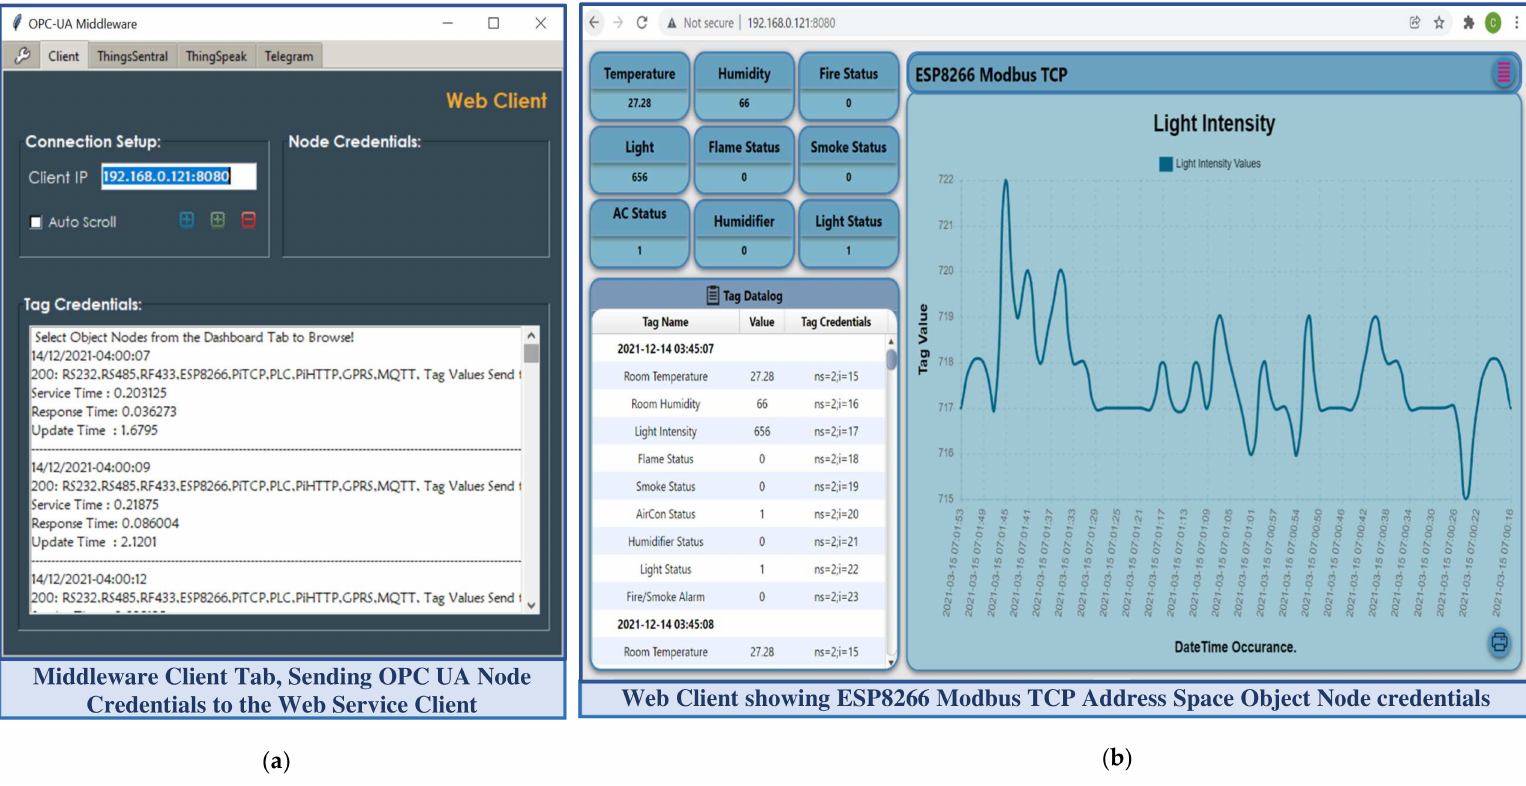
Figure 7. ( a ) Middleware application client tab; ( b ) middleware data monitoring in web